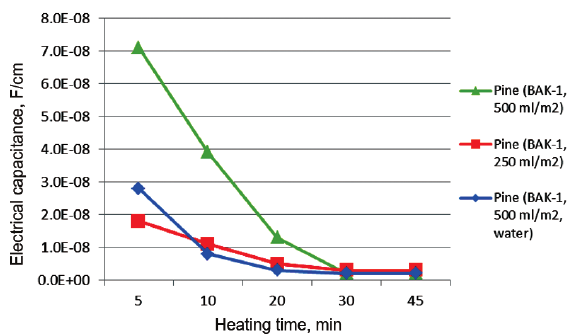
fig. 4. the dependency of the average electrical capacitance on heating time for media 3, 4 and